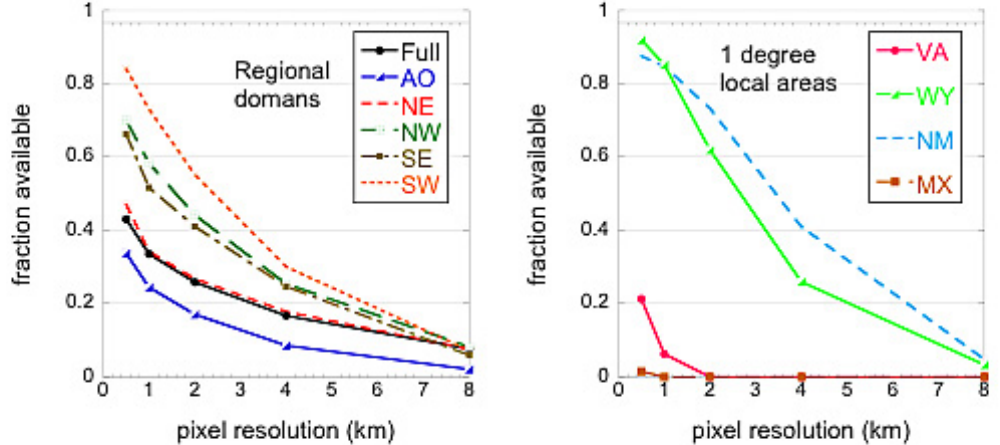
Fig. 8. (left) Aerosol retrieval availability for 12 August 2010 for the full domain and five subdomains defined by Fig. 5, and (right) for the four 1-degree squares representing local areas, as defined in Fig. 9.